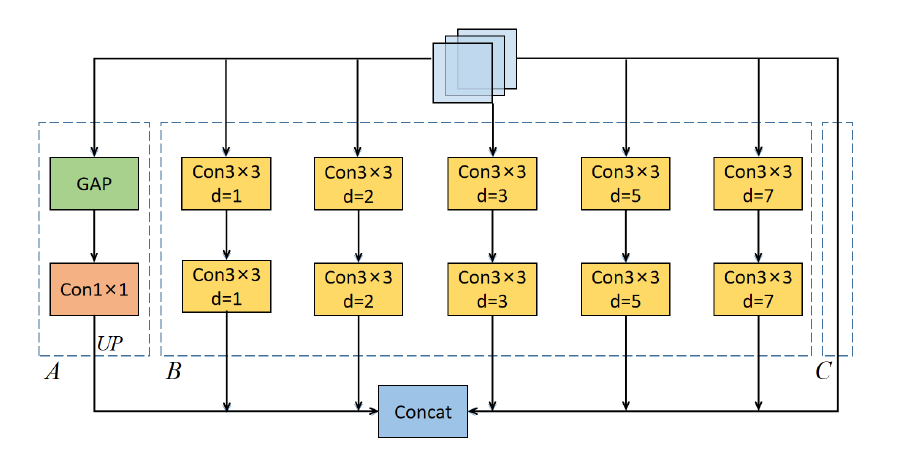
Figure 1. The structure of our proposed multi-scale context extraction module. It contains three parts namely A, B, and C. Part A extracts global information. Part B is the parallel connection of atrous convolutions with different dilatation rate. Part C is the feature map itself. GAP stands for global average pooling. Con1 × 1 represents a 1 × 1 convolution layer. UP denotes upsample operation. Concat means that the features are concatenated according to